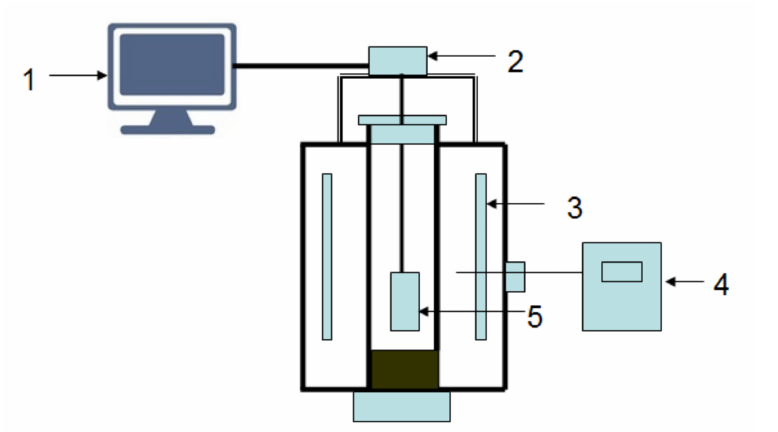
Figure 1. Schematic diagram of experimental apparatus. 1—computer; 2—electronic scales; 3—heater; 4—control apparatus;